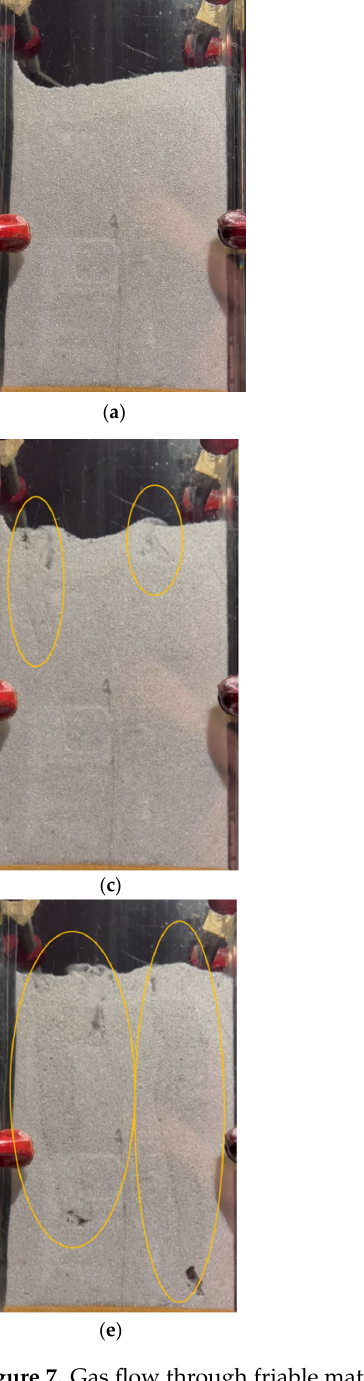
Table 2. Parameters used in data processing.